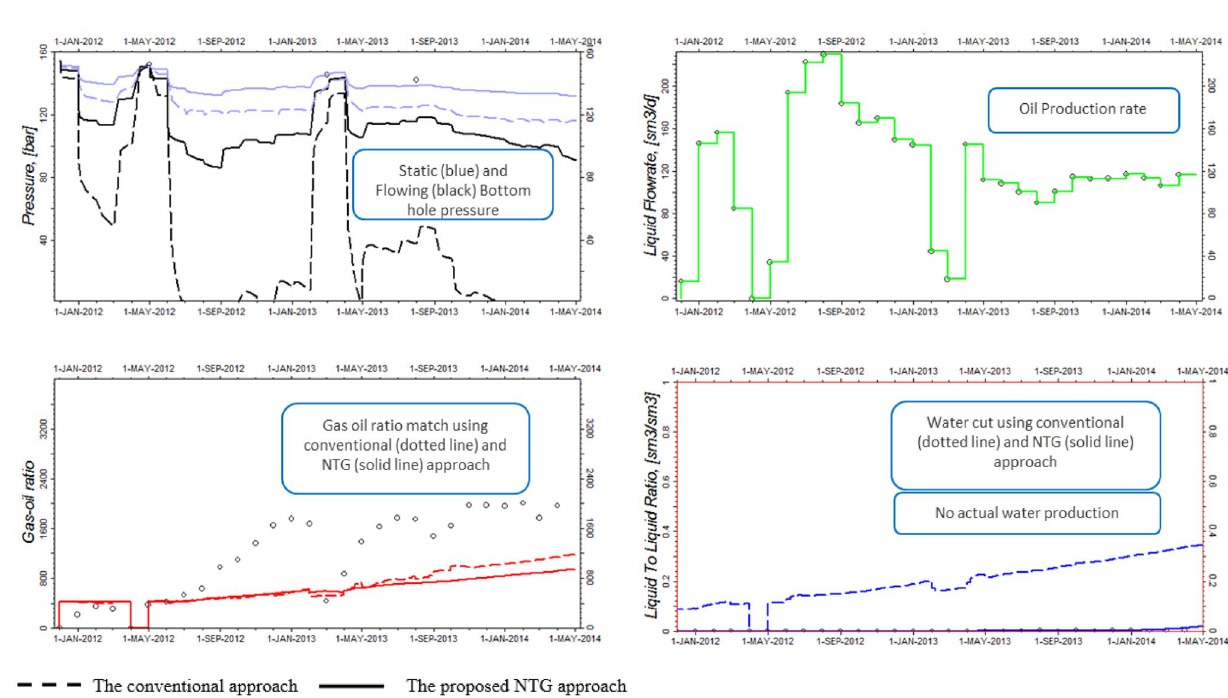
Fig. 12 Comparing the history match performance of a well using conventional total porosity approach and proposed NTG approach. Oil production rate (upper right), Static and flowing bottom hole pres- sures (upper left), gas-oil ratio (bottom left) and water cut match (bot-